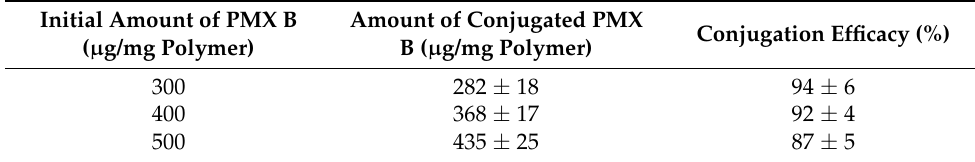
Table 3. Efficacy of PMX B conjugation with P(VSAA- co -VSI) depending on the initial amounts of antibiotic.